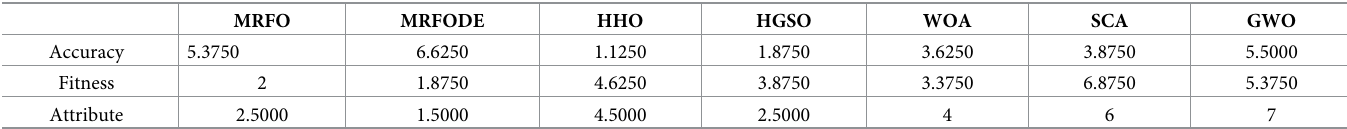
Table 4. Mean rank obtained using Friedman test for each